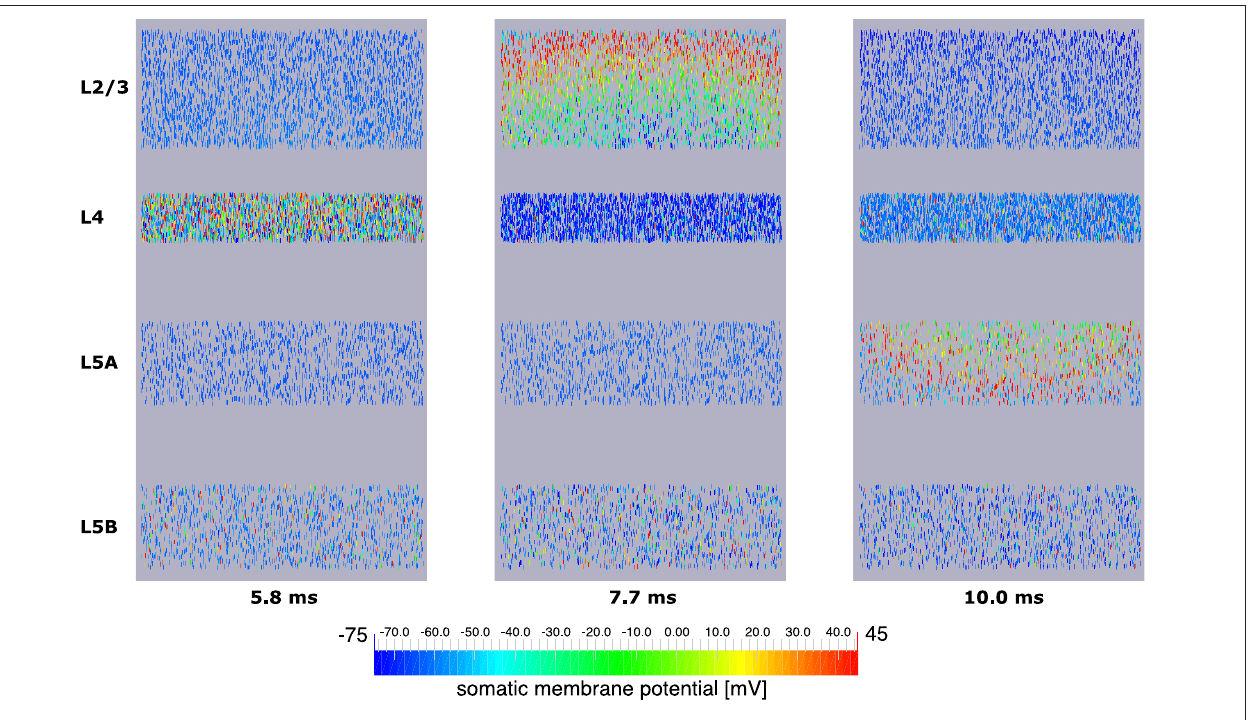
FIGURE 10 | Signal propagation through a neocortical slice of 10,000 neurons. Only somata are visualized. Primary excitation of L4 spiny stellate cells (left) is followed by activation of somata of L2/3 pyramidal cells (middle), before the signal propagates to pyramidal neurons of layer 5A (right). Note how the depolarization of somata expands through layers 2/3 and 5A like a wavefront indicating increased signal run time to neurons more remote with respect to the signal origin.